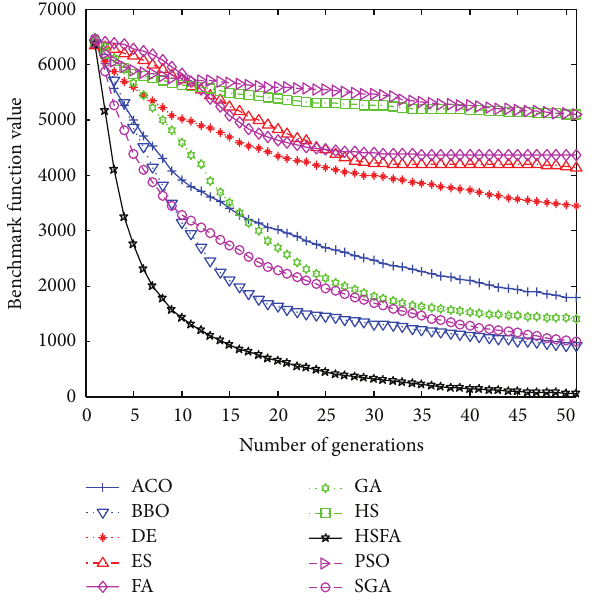
Figure 2: Performance comparison for the F28 Schwefel 2.26 function.